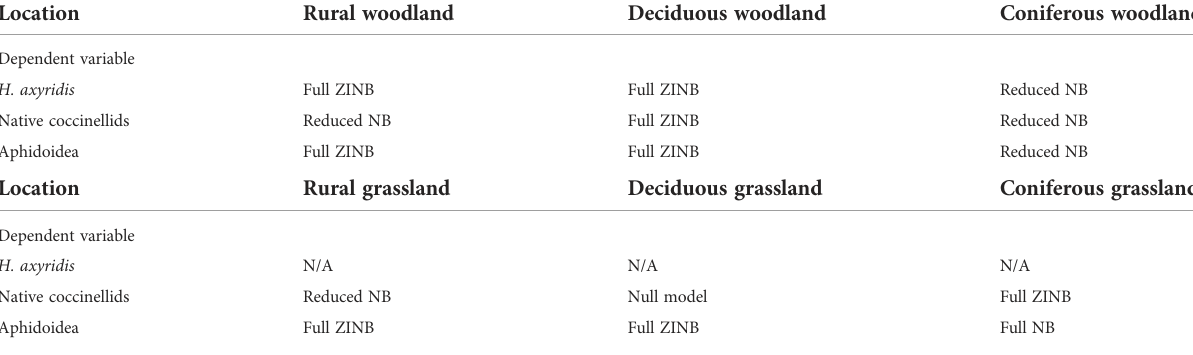
TABLE 2 Final model that was best fi t when variables applied under the following